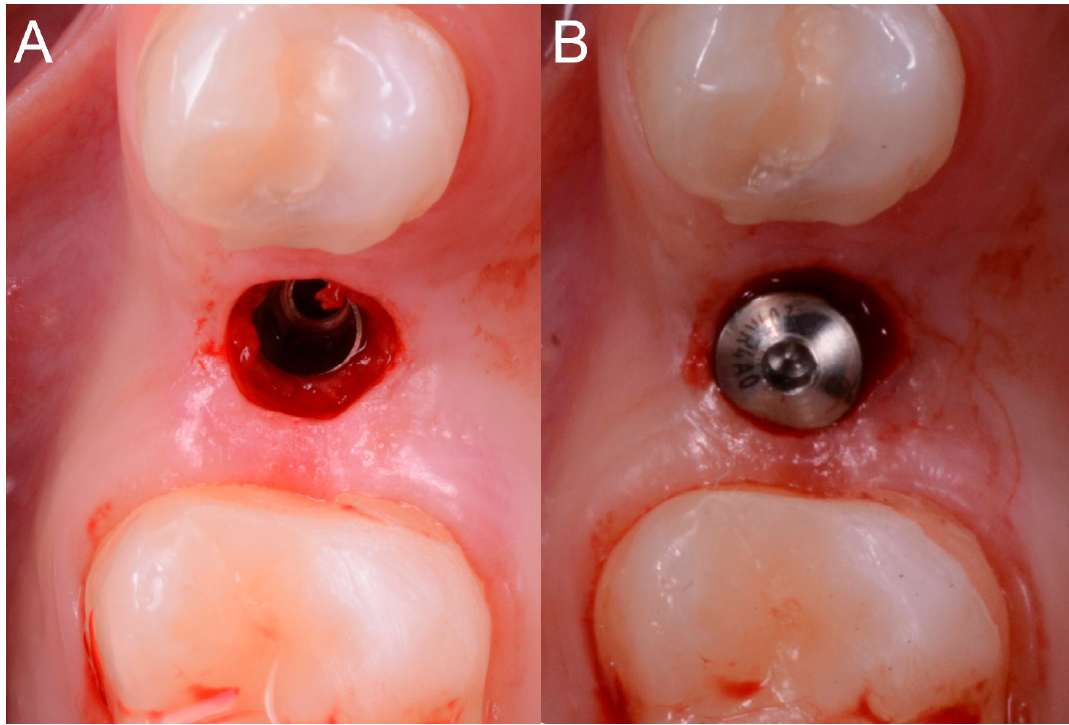
Figure 9. Implant positioning. ( A ) The implant (BT Safe Bone Level, BTK, Dueville, Italy) is inserted through the guide, in the planned position, inclination and depth; ( B ) The healing abutment is positioned.